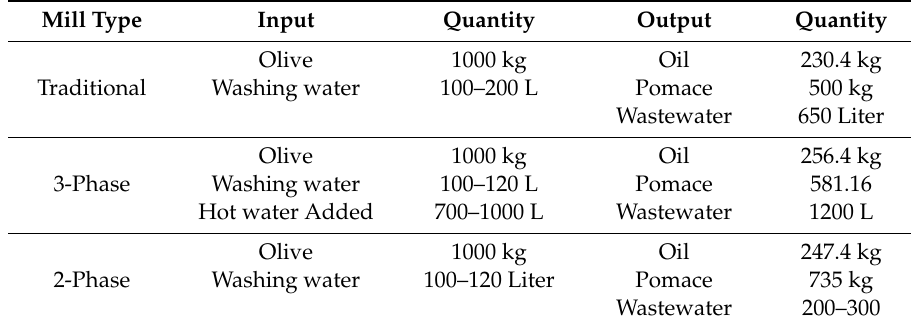
Table 1. Approximate input output analysis of water consumption and byproducts generated at olive oil mills